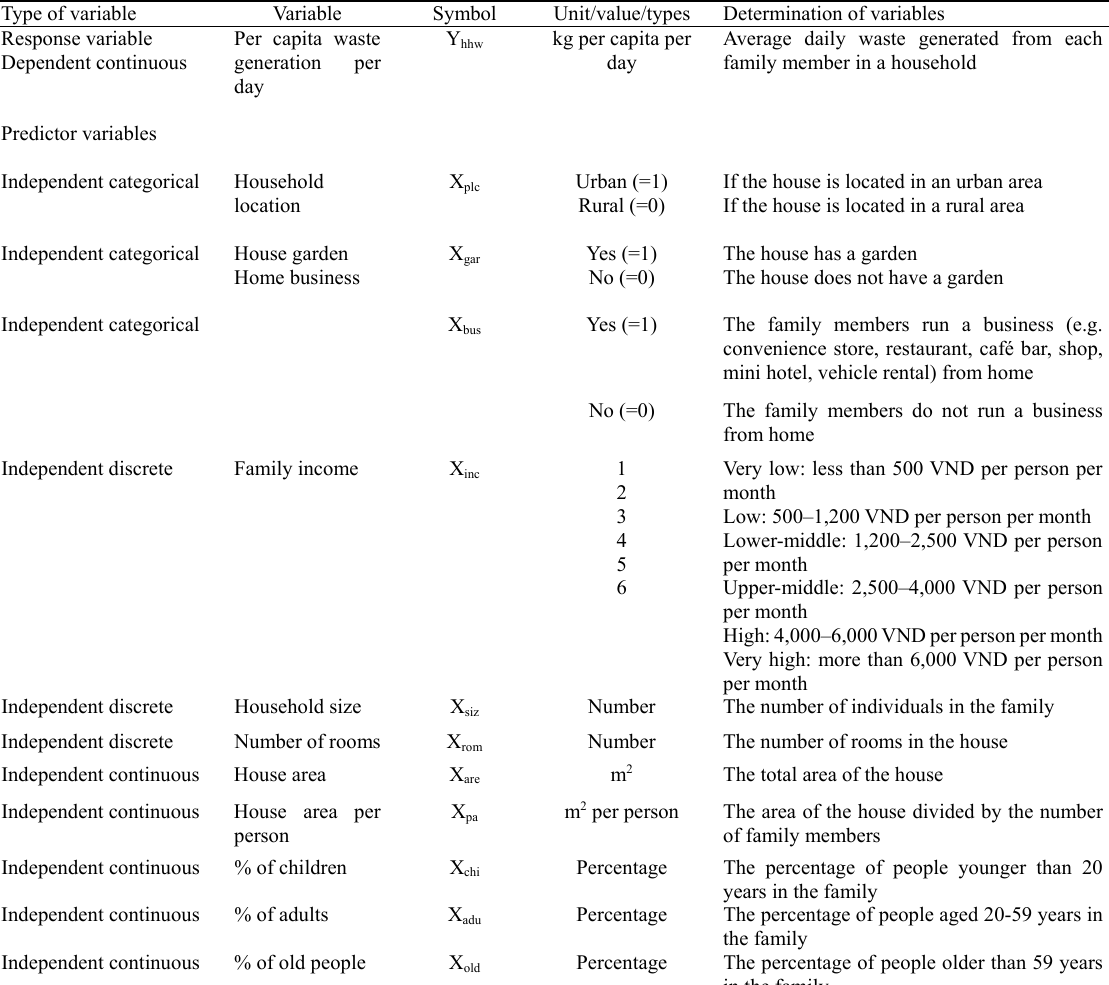
Table 1: Types of variables in linear regression